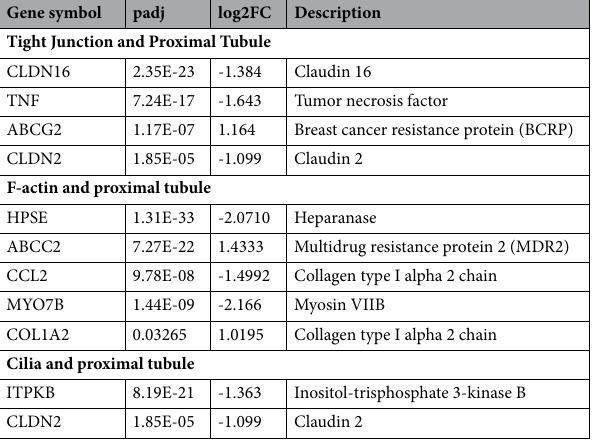
Table 2. Expression of selected genes with mechanistic and functional relevance to tight junctions, f-actin, and cilia in proximal tubules. Tables of differential expressed genes corresponding to morphological terms that were highly significant (padj < 0.05).